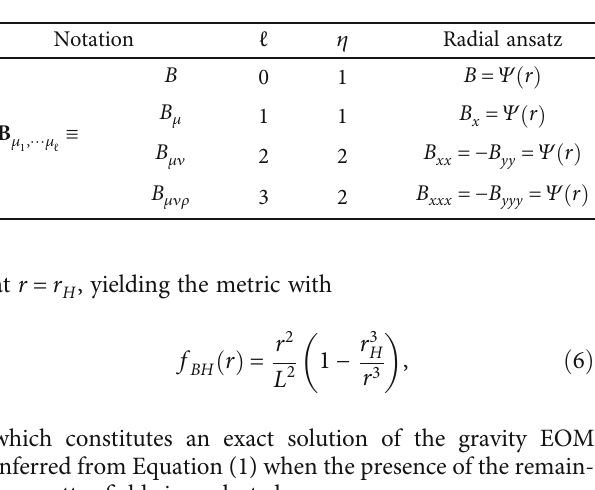
Table 1: Convenient ansatz for the matter fi elds in the s- [4, 5], p- (adapted from [6]), and d-wave [9, 10] and hypothetical f-wave holographic superconductors ( η being the multiplicity of Ψ in each case). For each ansatz, every component that is not mentioned